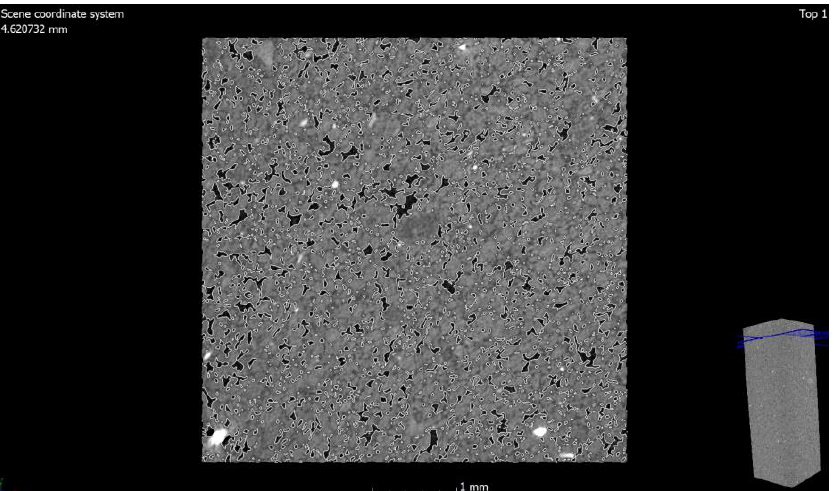
Figure 11. Cross-section through a sample of silicate material modified with glass sand. The drawings show a high number of small air voids.